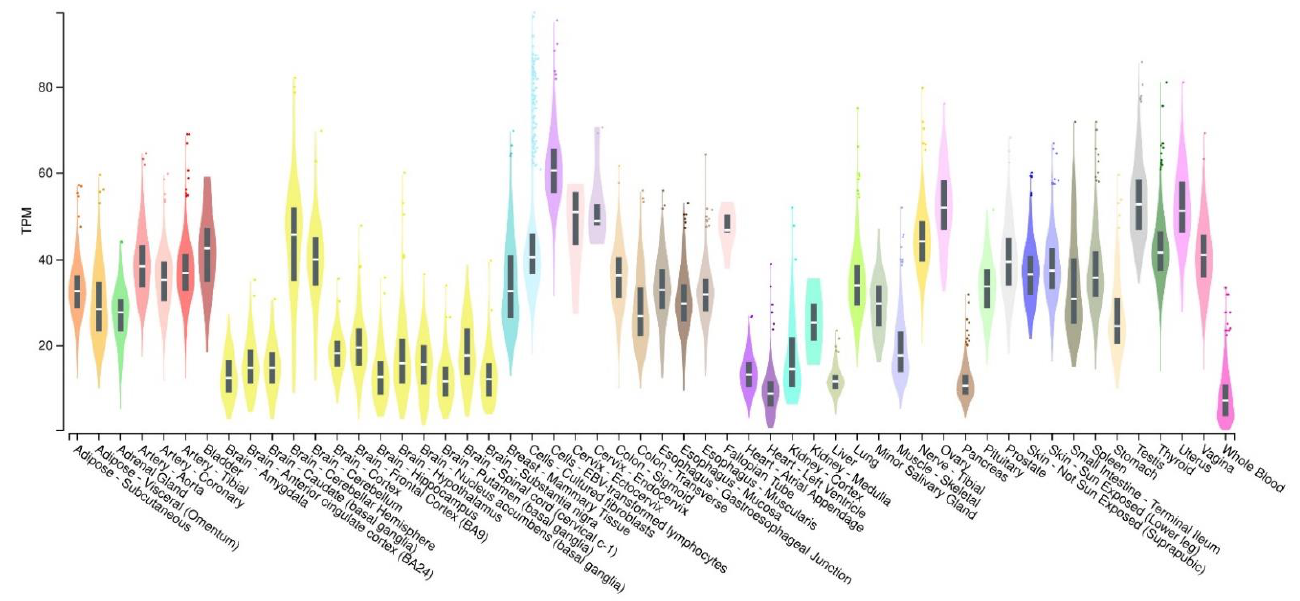
Figure 2. Boxplot of transcripts per million (TPM) showing the bulk tissue gene expression for ADNP. GTEx Portal on 29 September 2022.